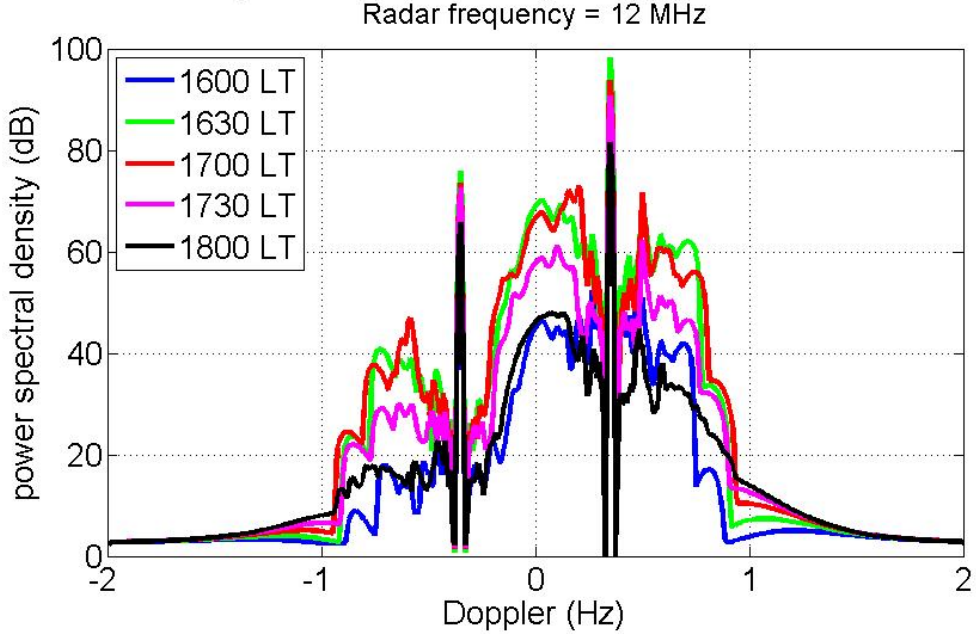
Figure 32. Sea clutter Doppler spectra computed from raw buoy measurements of wave spectra during the lifetime of a convective cell near Bathurst Island, Northern Australia. Noise in the buoy measurements is reflected in the Doppler spectra, but the transient and return to the pre-event state are unmistakable.